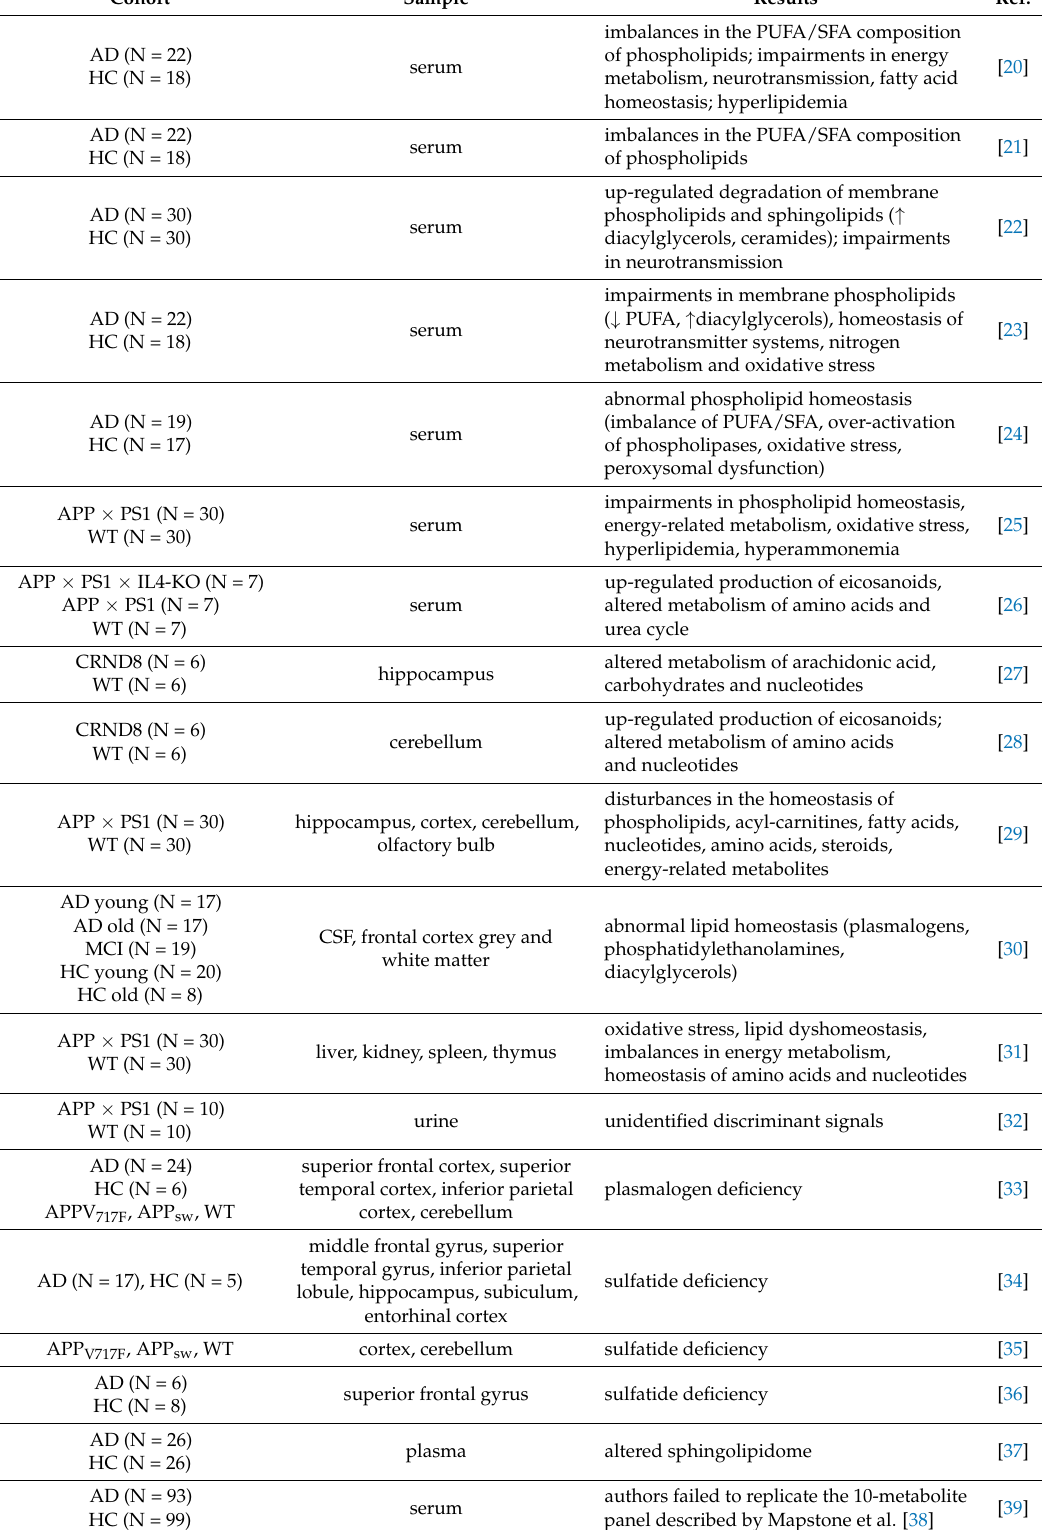
Table 1. Summary of DMS-based metabolomics studies on Alzheimer’s